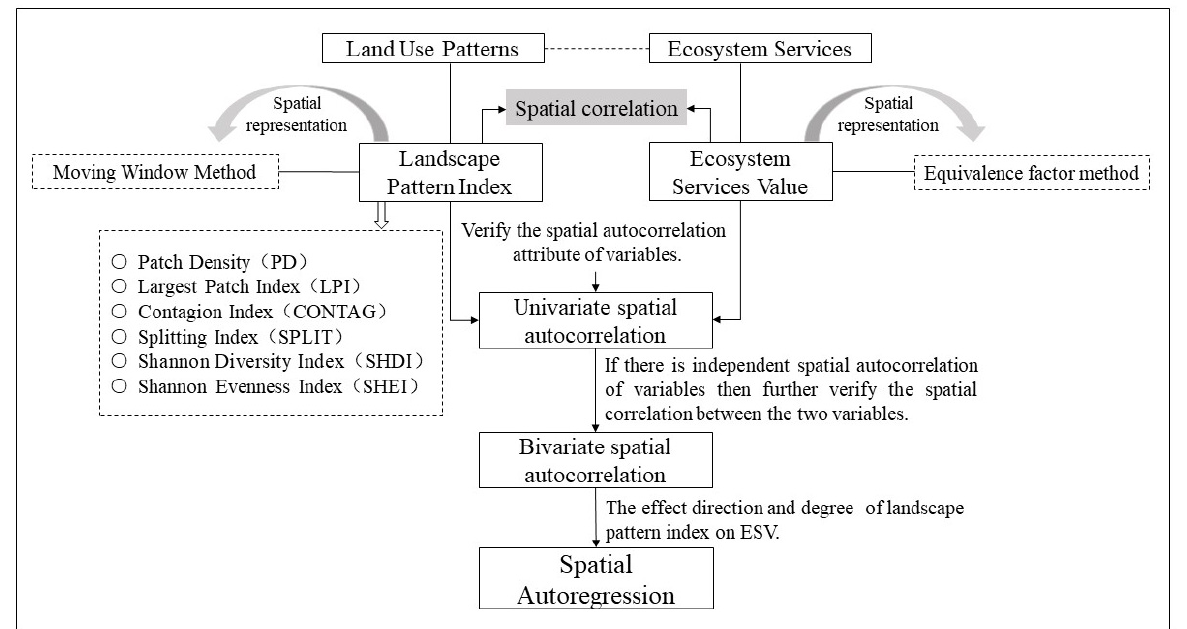
Figure 2. Technical framework.